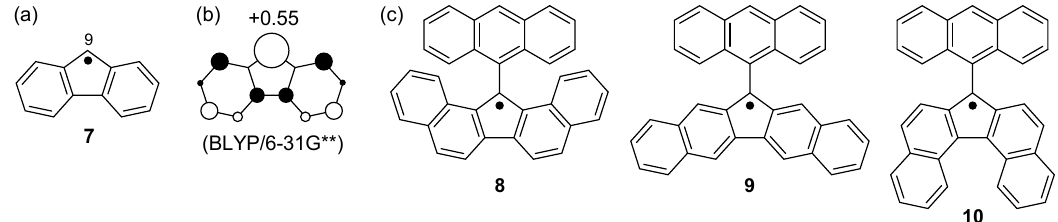
Figure 7. ( a ) Fluorenyl radical ( 7 ). ( b ) Spin density of 7 calculated by a BLYP/6-31G** method. ( c ) Anthryl-protected dibenzo-fluorenyl radicals ( 8 , 9 , 10 ).